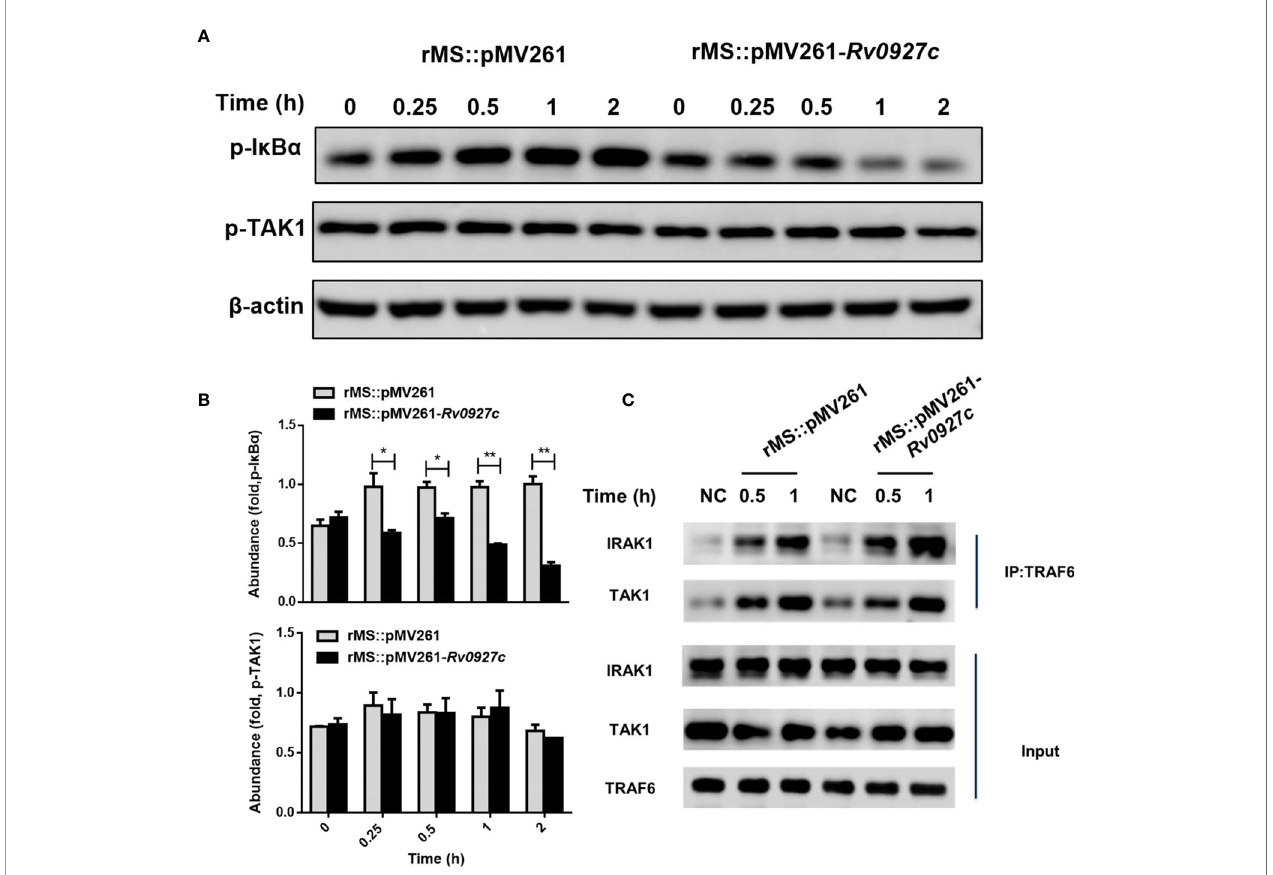
FIGURE 6 | Rv0927c attenuates M. smegmatis -induced activation of NF- k B by suppressing the phosphorylation of I k B a . (A) Immunoblot analysis of phosphorylated I k B a and TAK1 and total b -actin in RAW264.7 cells infected for 0 – 2 h with rMS::pMV261 and rMS::pMV261- Rv0927c . (B) Densitometry quanti fi cation of results for (A) presented relative to those of b -actin. (C) Immunoblot analysis of proteins immunoprecipitated with anti-TRAF6 from lysates of RAW264.7 cells infected with recombinant M. smegmatis strains. * P < 0.05 and ** P < 0.01 (unpaired two-tailed Student ’ s t test). Data are representative of experiments with at least three independent biological replicates (mean and sem of n = 3